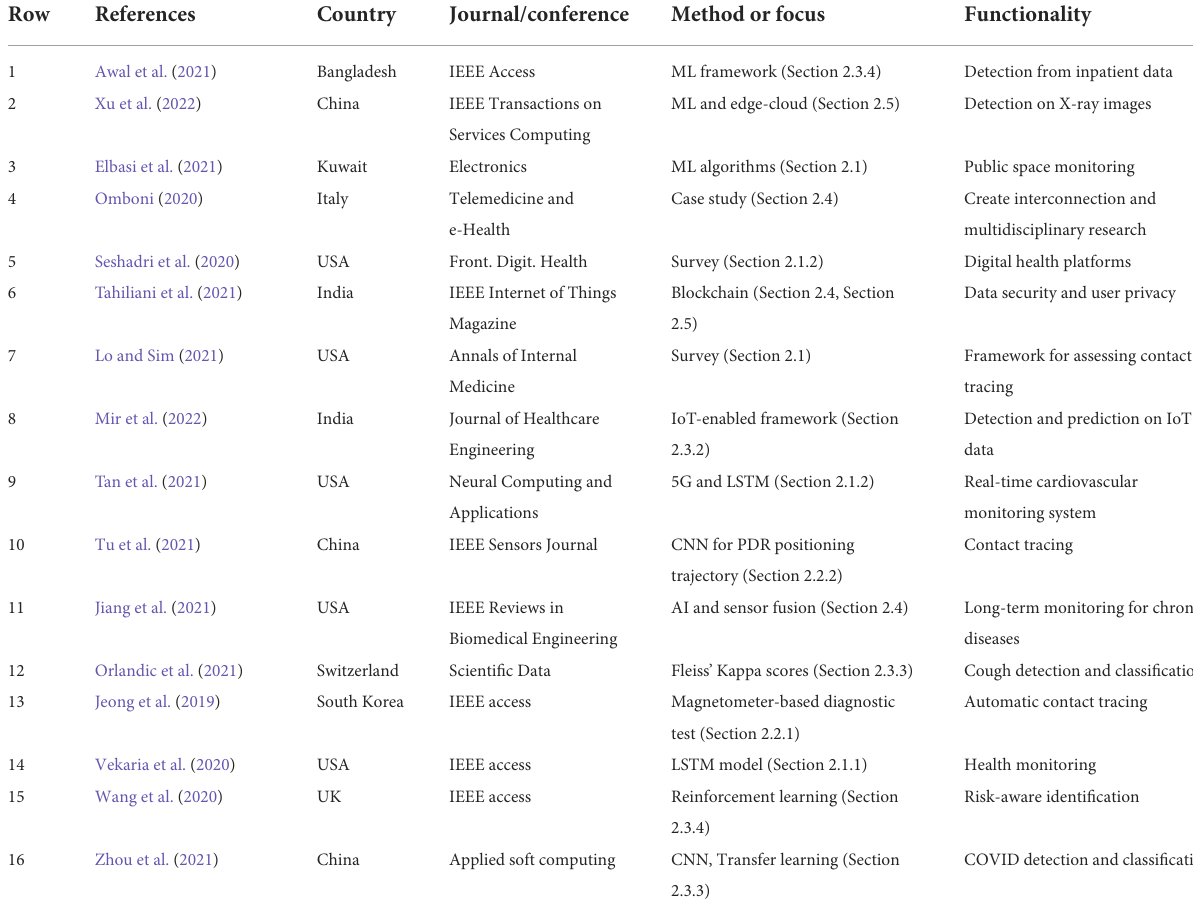
TABLE 3 Summary of selected papers in this survey as illustration